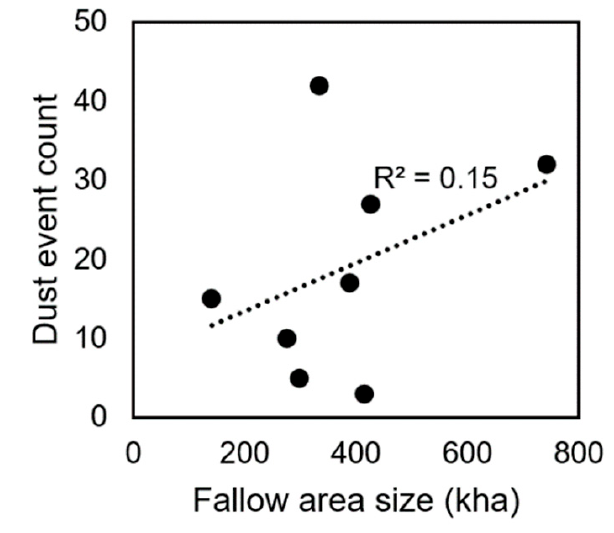
Figure 2. The yearly fallow area size versus the dust event count. Data from Eckardt et al. [33] and the Department of Agriculture, Forestry and Fisheries (DAFF).